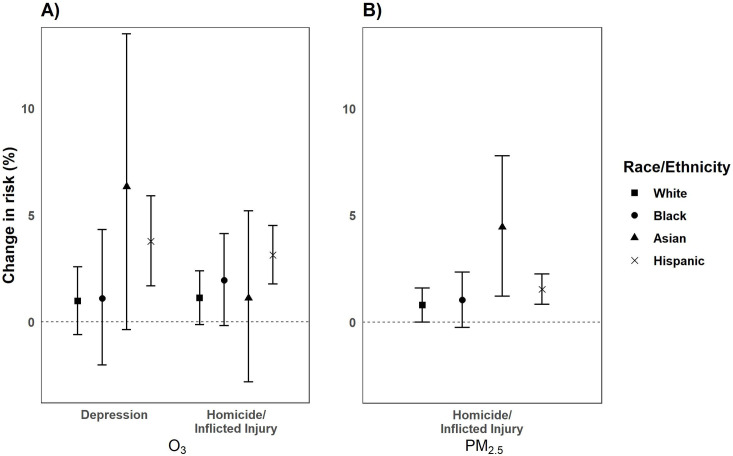
Percentage change (95% CI) in the risk of ED visits for O3 (per 10 ppb increase) (A) and PM2.5 (per 10μg/m3 increase) (B) by race/ethnicity from 2005–2013 in California.1 Bars: 95% Confidence Interval; CI: Confidence Interval; ED: Emergency Department; ppb: parts per billion. 1Only significant outcomes shown.